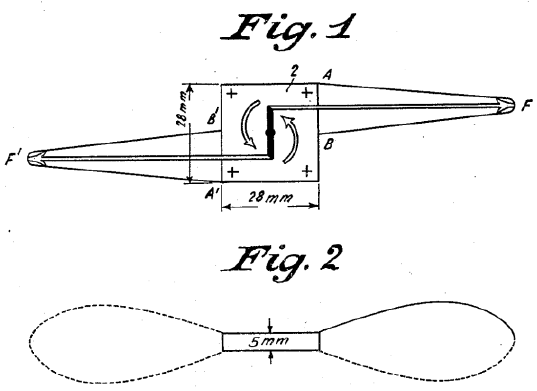
Figure 1. Piezoelectric oscillating element to obtain mechanical movement as described in the US Patent invented by Meissner [1].